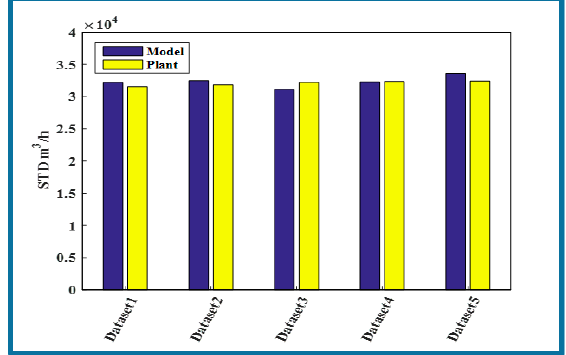
Figure 14. Predictions of H 2,makeup flow rate for the residue hydrorefining process. STD m 3 h − 1 is the volume flow per hour of fluid at 15.556 ◦ C and 101.325 kpa.